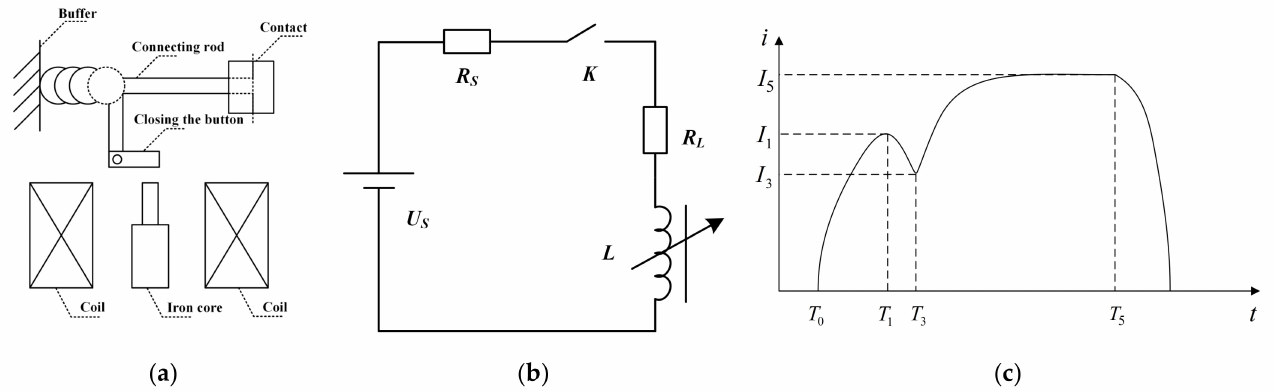
Figure 1. Model of HP550B2 breaking solenoid with coil equivalent circuit diagram and its closing current waveform: ( a ) split-close solenoid model; ( b ) coil solenoid equivalent circuit diagram; ( c ) coil current